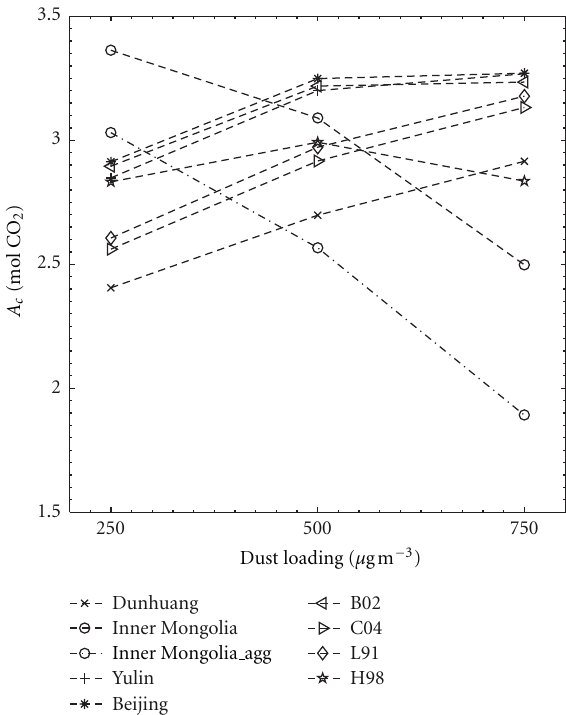
Figure 10: Carbon assimilation rate calculated with the LUE model of Roderick et al. [8] as a function of dust loading for all dust cases.